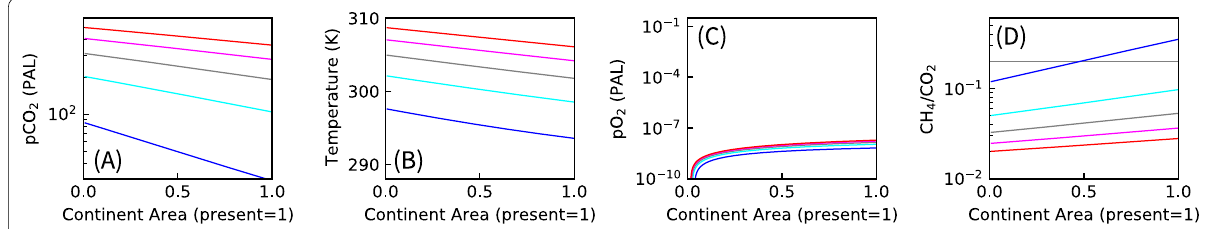
Fig. 4 Response of the system against continental growth with Archean-like ecosystem. The dependence of A p CO 2 , B surface temperature, C p O 2 (PAL), and D CH 4 /CO 2 ratio on the continental area, calculated in the case of high primary productivity of the anaerobic photoautotrophs ( F red 2.00 10 13 mol C year –1 ), bioavailable fraction of the riverine phosphorus ( γ bio = × spreading rate (1.307 times the present rate), and soil biological activity ( f e present CO 2 outgassing rate are shown with blue, cyan, grey, pink, and red lines,